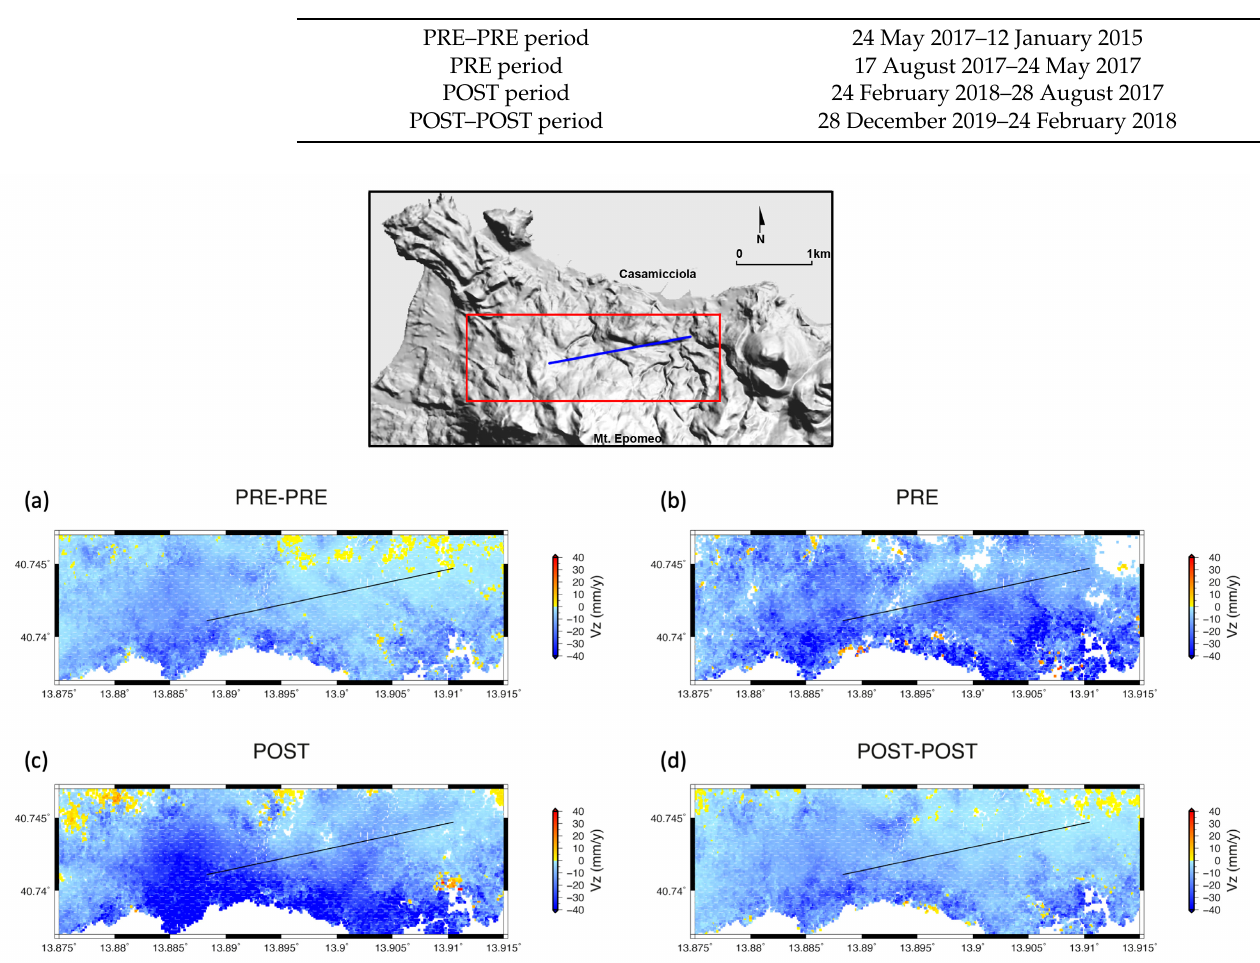
Figure 4. Velocity of the vertical ground motion as obtained from the analysis of DInSAR data, for the four time periods indicated in Table 1. Only the points with velocity larger than the standard deviation σ are shown ( σ is reported in Supplementary Figure S4). The maps displayed in panels ( a – d ) correspond to the area enclosed in the red rectangle in the map on top. The results are evidence of very similar velocities of the ground subsidence in the PRE–PRE (Figure 4a) and POST–POST (Figure 4d) periods, indicating that, apart from 9 months across the earthquake, the vertical deformation in the sector north of Mt. Epomeo is remarkably stable. The geographical distribution of the velocity in these two periods is characterized by a general trend of subsidence of the whole area, superimposed by a large patch of faster velocity extending west and northwest of the fault line. This area